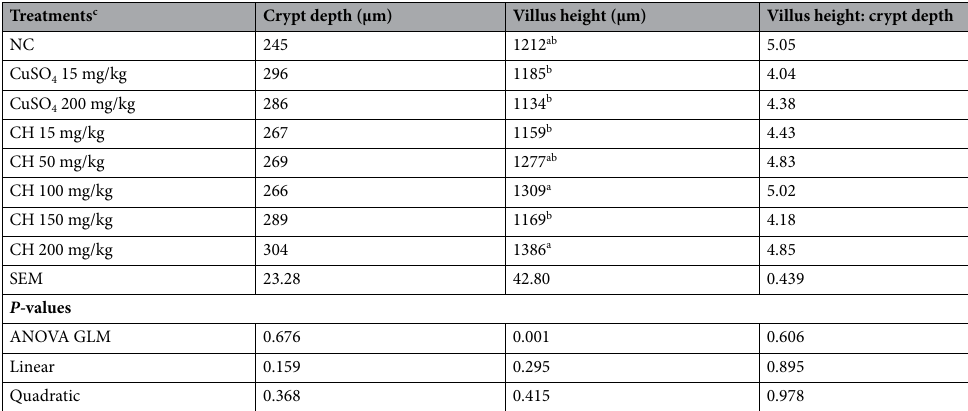
Treatments c Crypt depth